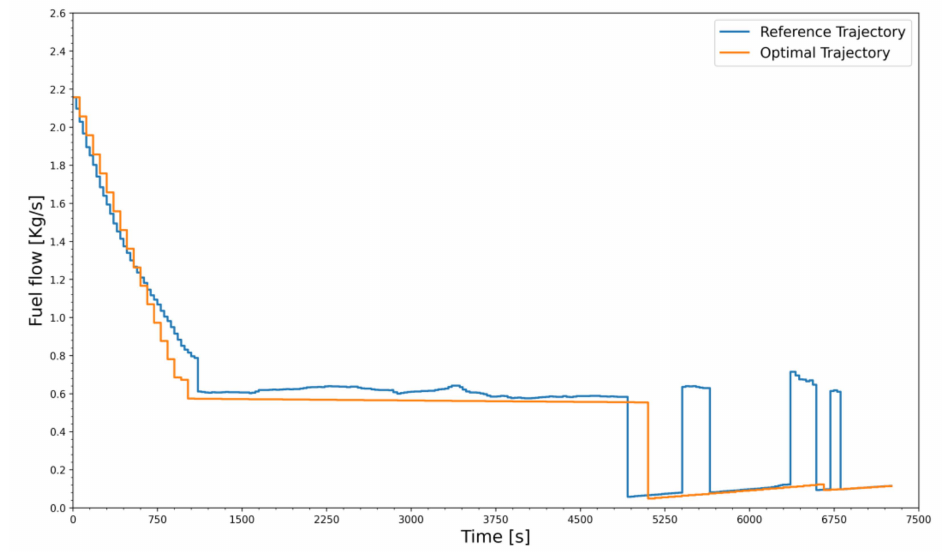
Figure 5. Comparison of fuel-flow rate vs. time of reference and fuel-optimal trajectory.